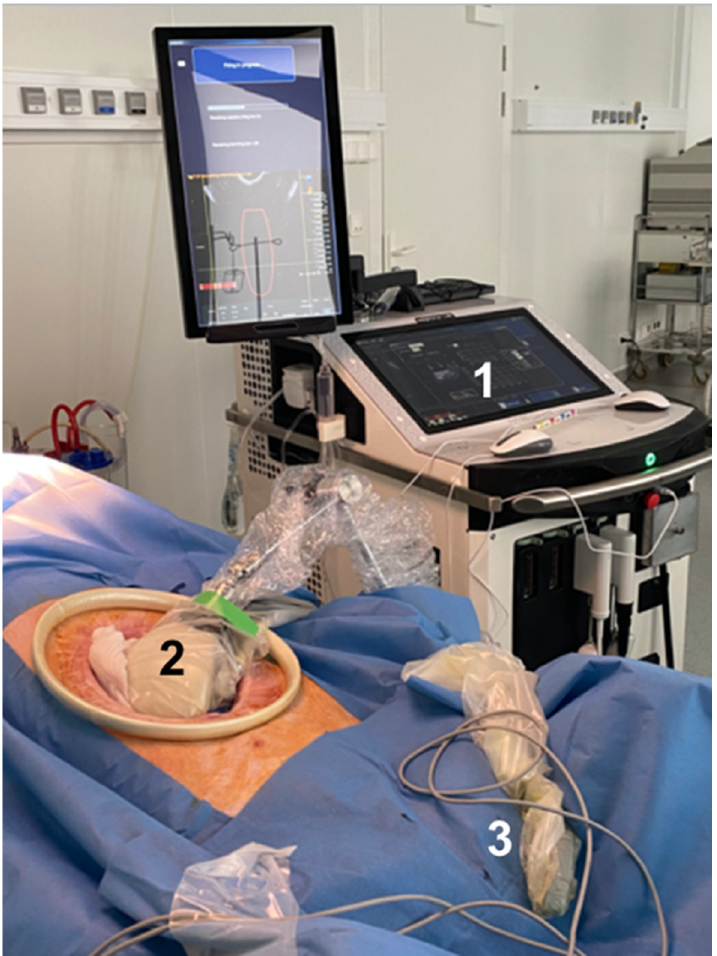
Figure 2. Experimental setup during in vivo treatment. 1: Electronic system used to control the HIFU transducer. 2: Intra-operative HIFU device. 3: Additional ultrasound imaging probe working at 14 MHz.